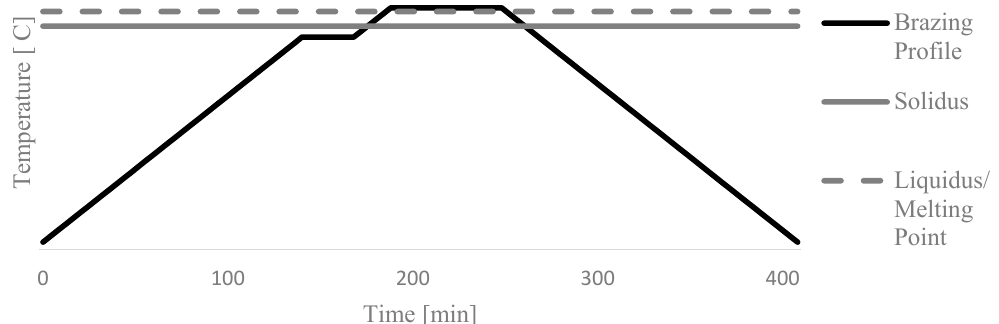
Figure 2. Generic brazing profile indicating dwell points below and above temperatures at which the braze material has melted.